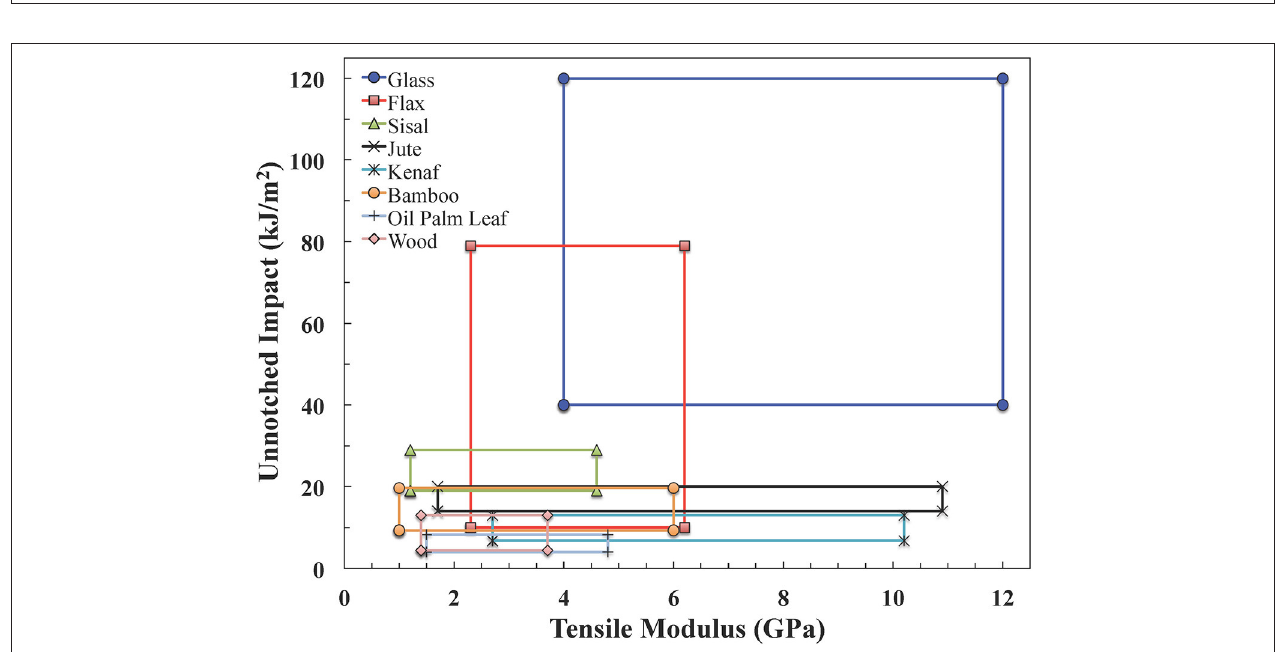
FIGURE 2 | Overview of the range of Unnotched Impact and Tensile Modulus covered by the papers in this review.